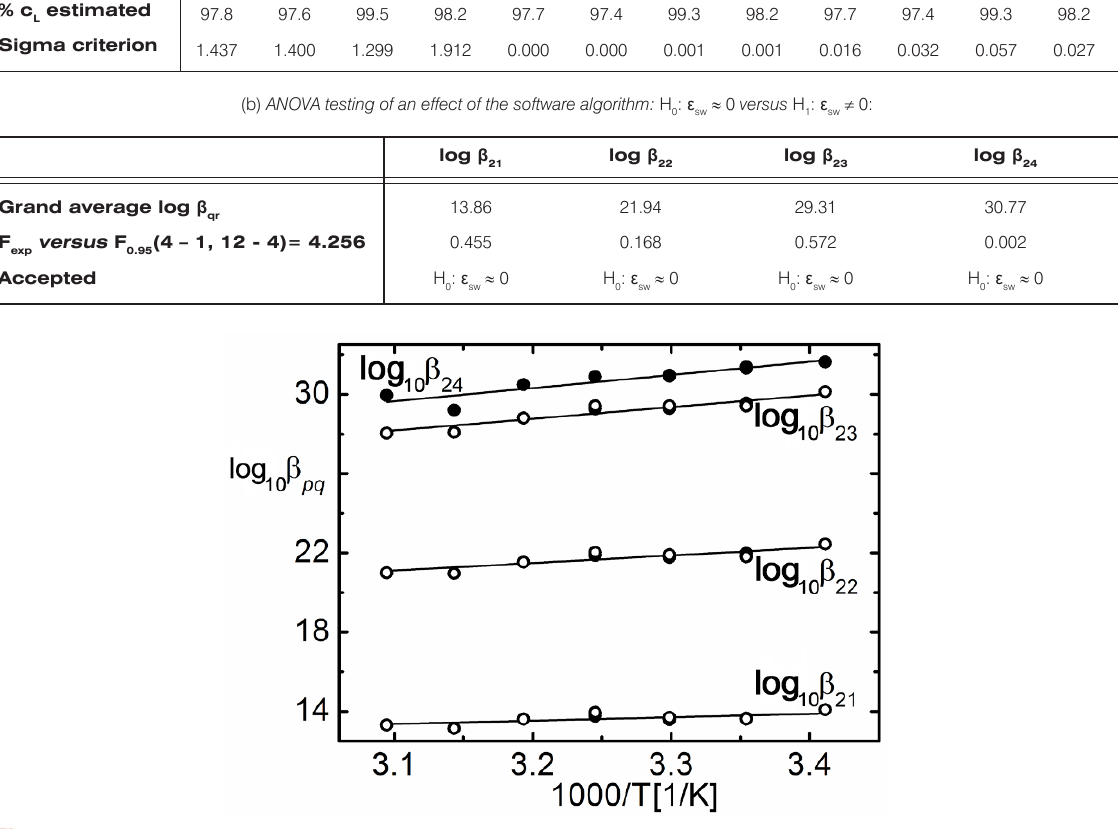
on temperature 1000/ T (T in K) enables a calculation of Δ H 0 and Δ S 0 β qr 10 variance of the same data as those leading to Table 1, i.e., for vildagliptin, shows that for all species formed the difference between titrations is larger than the variability within one titration. This is to be expected when data for different total drug concentrations (L) are treated,